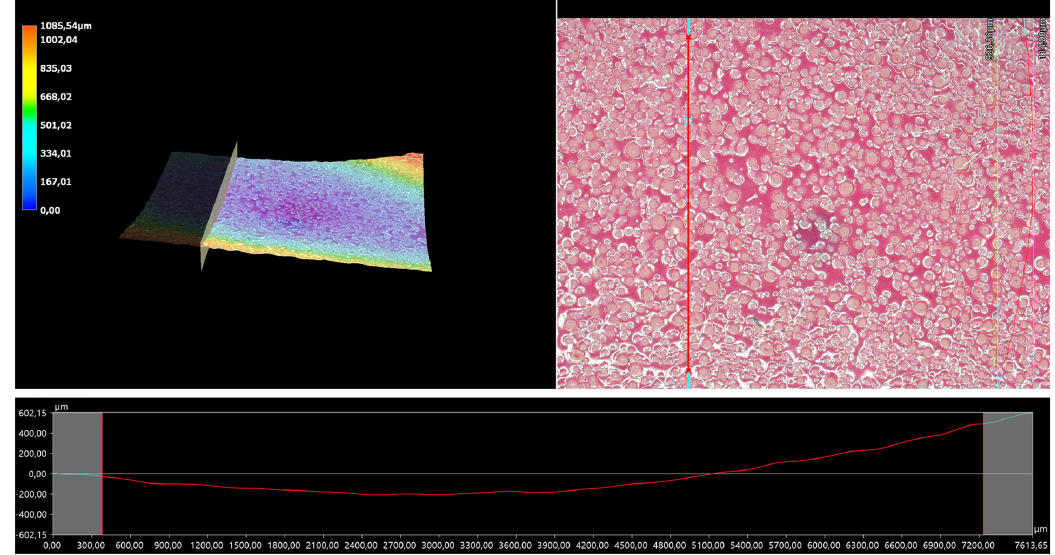
Figure 13. A 3D view of the roughness profile of sample 0.125/Photo.